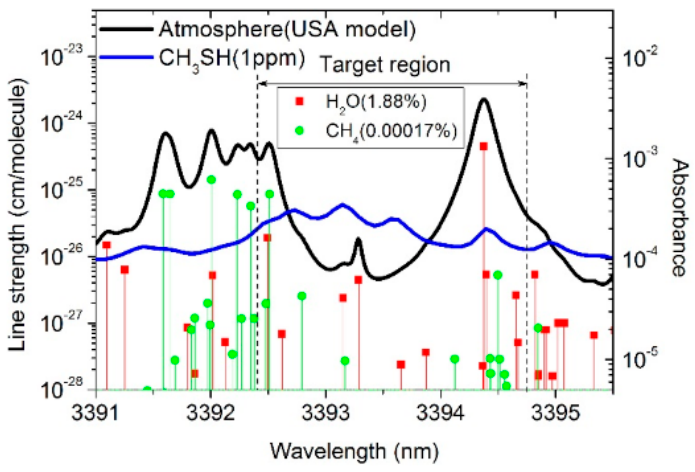
Figure 2. Absorption spectrum and line strength of the USA atmospheric model (mean latitude, summer, H = 0, from the HITRAN database) versus absorption spectrum of CH 3 SH at 1 ppm (from the PNNL database) and in 3391–3395.5 nm.